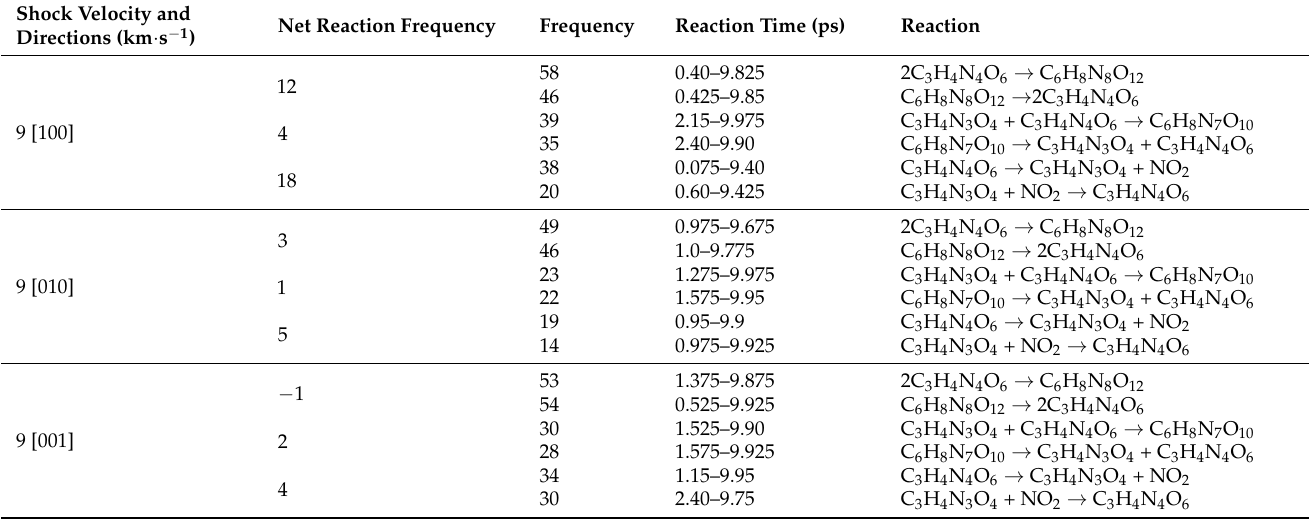
Table 4. Reactions of TNAZ in the first 10